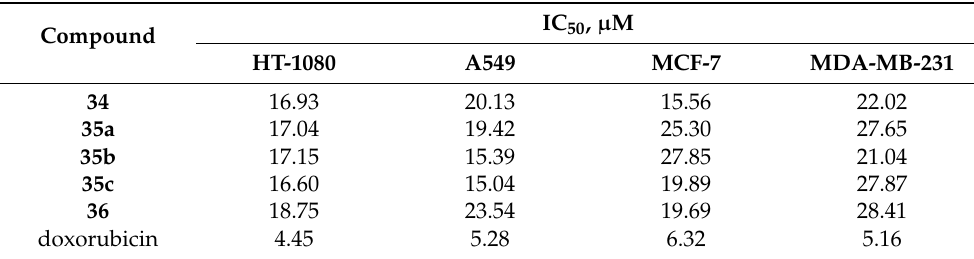
Figure 16. The thiazolidin-4-one carvone hybrids as anticancer agents. Table 4. Cytotoxic activity of Compounds 34 – 36 against HT-1080, A549, MCF-7 and MDA-MB-231 cell lines.